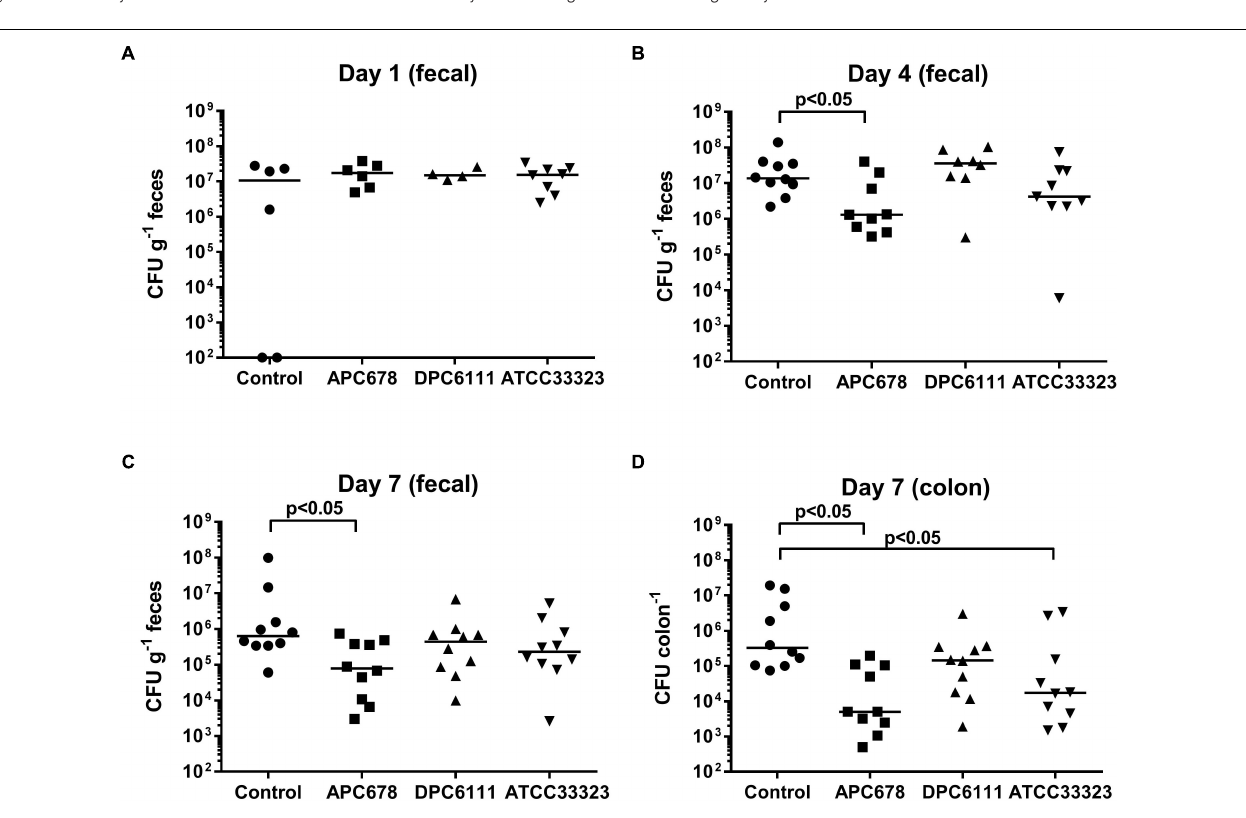
FIGURE 2 | Clostridium difficile detected during fecal shedding. C. difficile detected in mouse feces (CFU g − 1 feces) following (A) 24 h, (B) 4 days, and (C) 7 days administration of the test strains (or control); and (D) C. difficile levels in mouse colon (CFU colon − 1 ) following 7 days administration of test strains (or